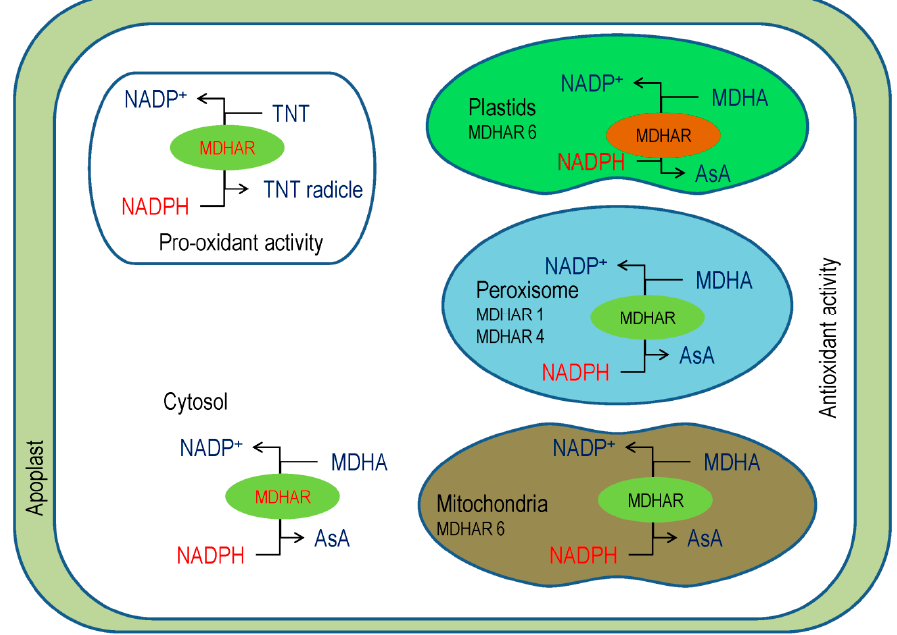
Figure 5. The antioxidant of MDHAR in regenerating AsA to support the removal of reactive oxygen species (ROS) (lower left) contrasts the pro-oxidant role of MDHAR creating 2,4,6-trinitrotoluene (TNT) toxicity.